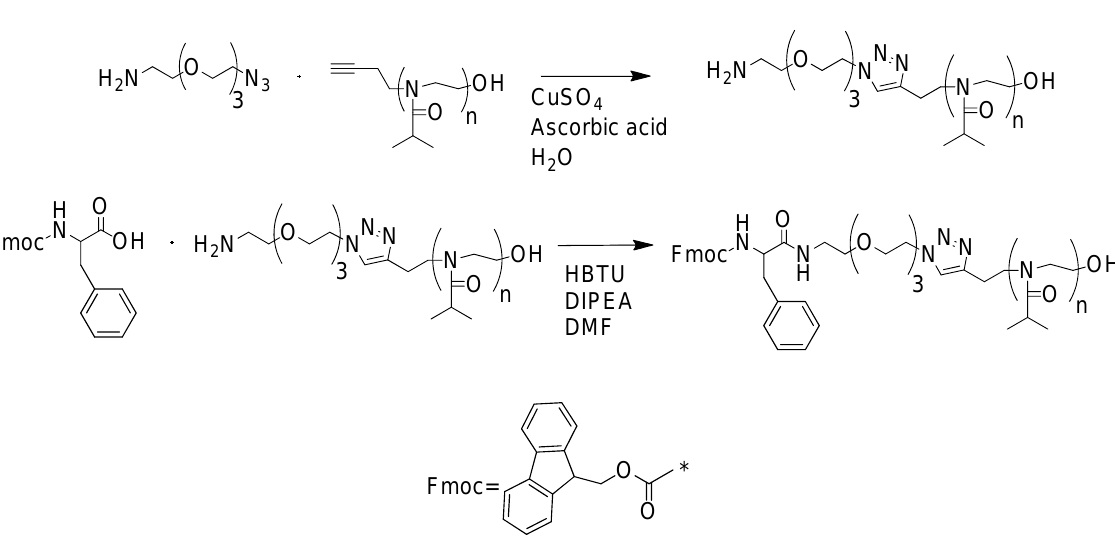
PiPrOx (Route B). ( a ) Click reaction was used to functionalise PiPrOx with PiPrOx bearing the primary amino group at the α -terminus with